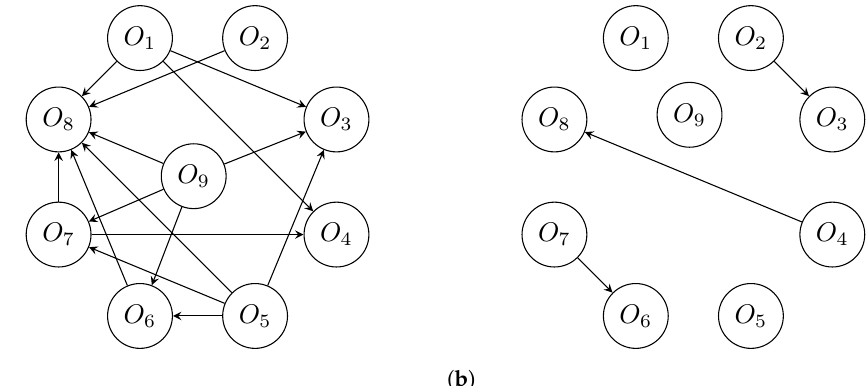
Figure 4. Strong and weak outranking graphs. ( a ) Strong outranking graph G F graph G f 1